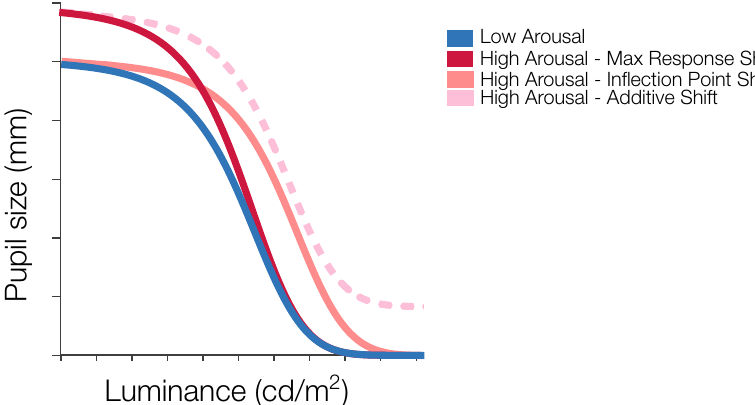
Figure 1. Possible effects of arousal on the pupillary light reflex response. The blue curve depicts the pupillary light response under a low arousal condition, while the different pink and red curves represent three possible modulations of the response under high arousal. The red curve illustrates a maximum response shift, in which arousal modulates pupil response at the low luminances. The solid pink curve illustrates an inflection point shift, or a horizontal shift of the curve, in which arousal’s modulation on the pupil response occurs at mid-, but not high- and low-luminances. Lastly, the dotted pink curve illustrates an additive shift, or an overall increase in pupil size with increased arousal across all luminance